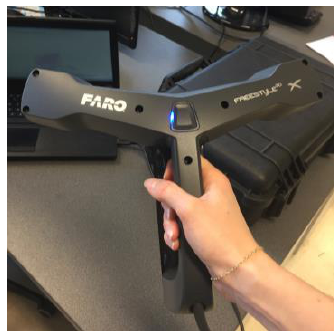
Figure 1. Freestyle 3D X handheld scanner